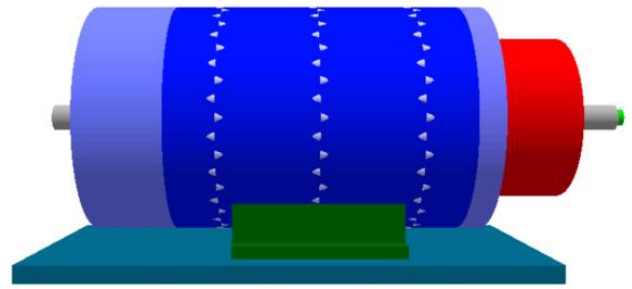
Figure 6. Water-cooled motor drawn using Motor-CAD.